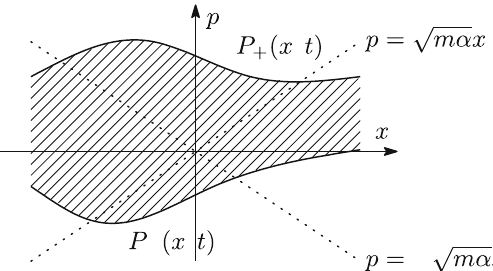
Fig. 2 The sketch of the fermions in the phase space. They compose the droplet(s) in the phase space. The doted lines describe the separatri- ±√ α/ mx . (Left) P + ( x , t ) and P − ( x , t ) (3.8) aretheupperand ces p = lower boundaries of the droplet, respectively. (Right) If the boundaries